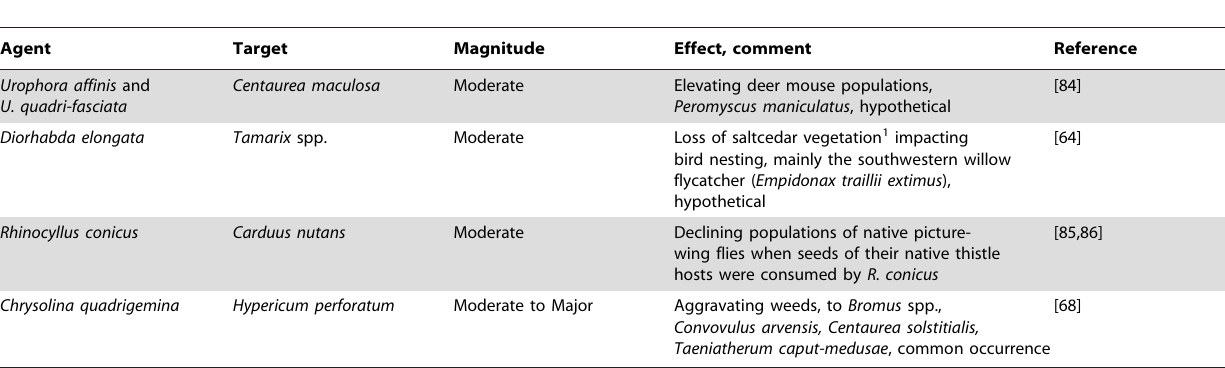
Table 5. Assessment of potential magnitude of indirect adverse ecological effects from biological control agents (including target weed removal).